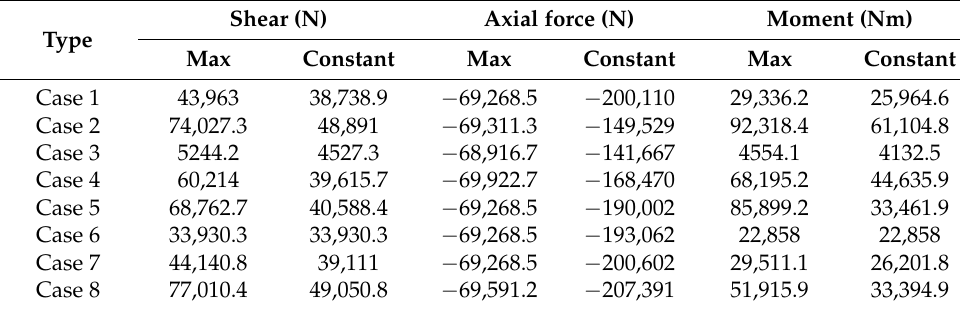
Figure 23. Column behavior after column removal in story six: ( a ) axial force, ( b ) shear, and ( c ) moment. Table 8. Result force story 13 for element